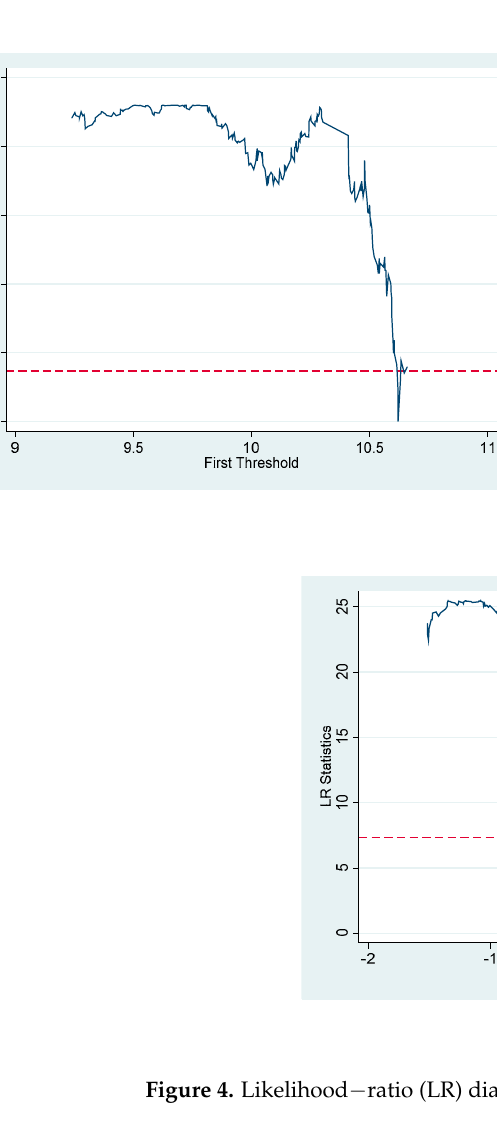
Table 5. Threshold regression results with PCDI level as the threshold variable.